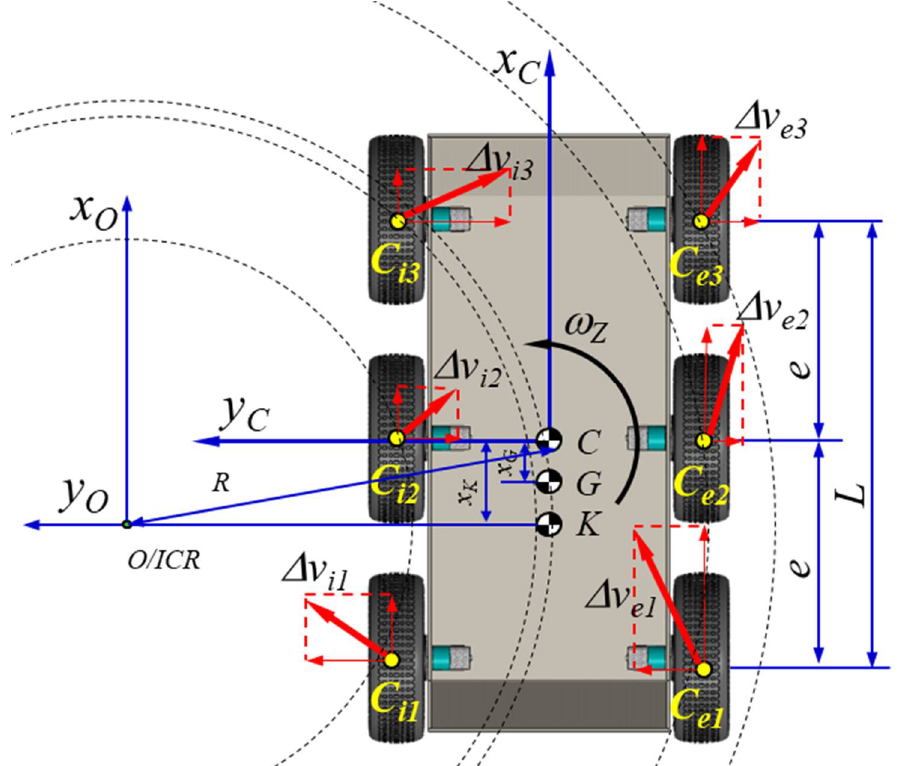
Figure 5. The 6 × 6 kinematic diagrams of the robot showing the following essential characteristics for a simple and fast analysis of the robot kinematics: the six driving wheels are not steering wheels; turns are made by changing the rotational speeds of the six wheels; cornering radii varied depending on the rotational speed of the drive wheels and the indices of adhesion to the ground, the slip indices. If the movement was rectilinear, the decomposition of the speed was uniform only for the ideal conditions of movement; the ground contact of the balloon of the wheels was related to the pressure in the balloon. The weight of the robot and the position of the center of gravity may be altered, in particular, by the operating platforms.